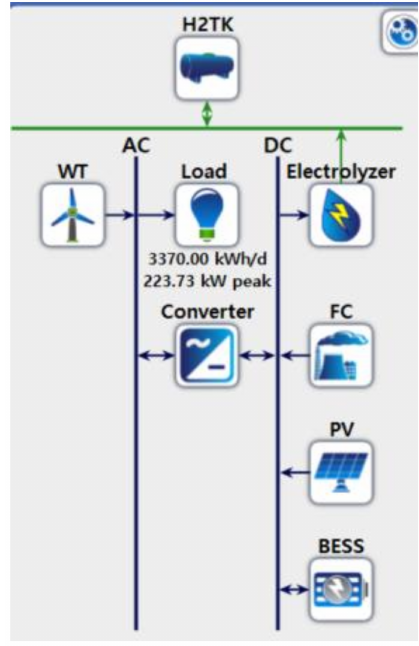
Figure 7. Microgrid topology_C in